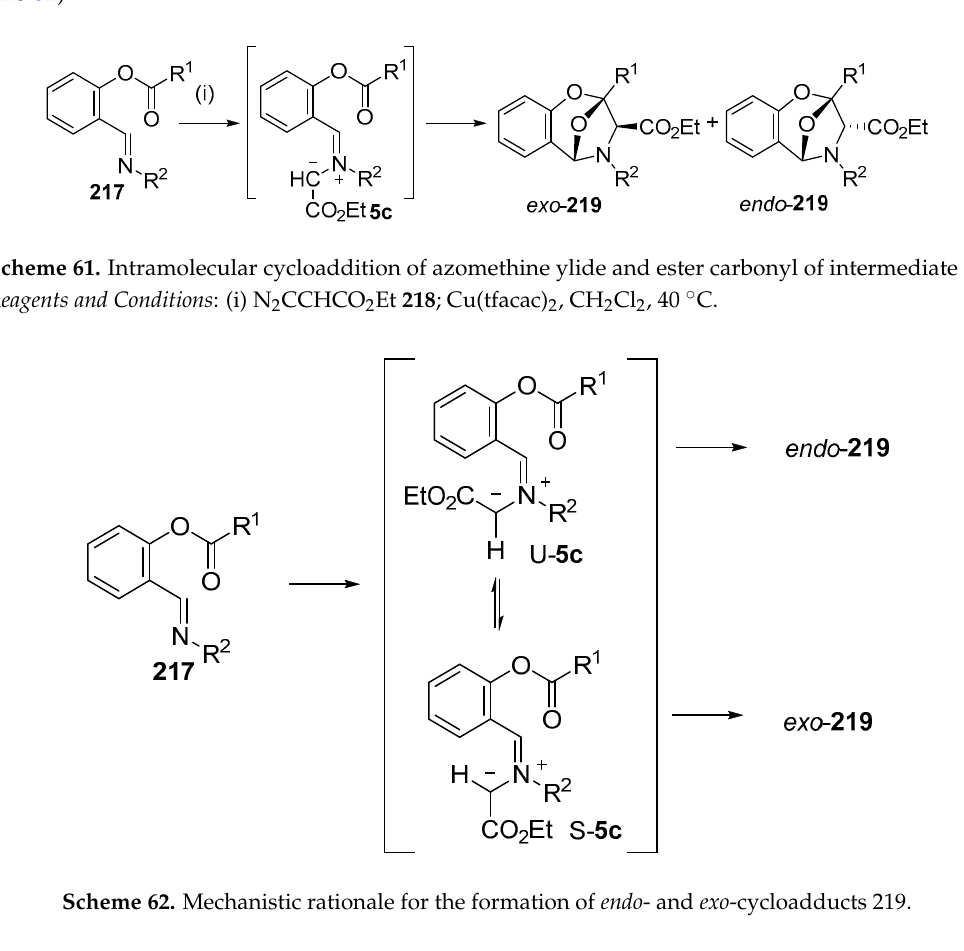
Table 29. Reaction of imines 217 , ethyl diazoacetate ( 218 ) and Cu(tfacac) 2 in CH 2 Cl 2 at 40 ˝ C (Scheme